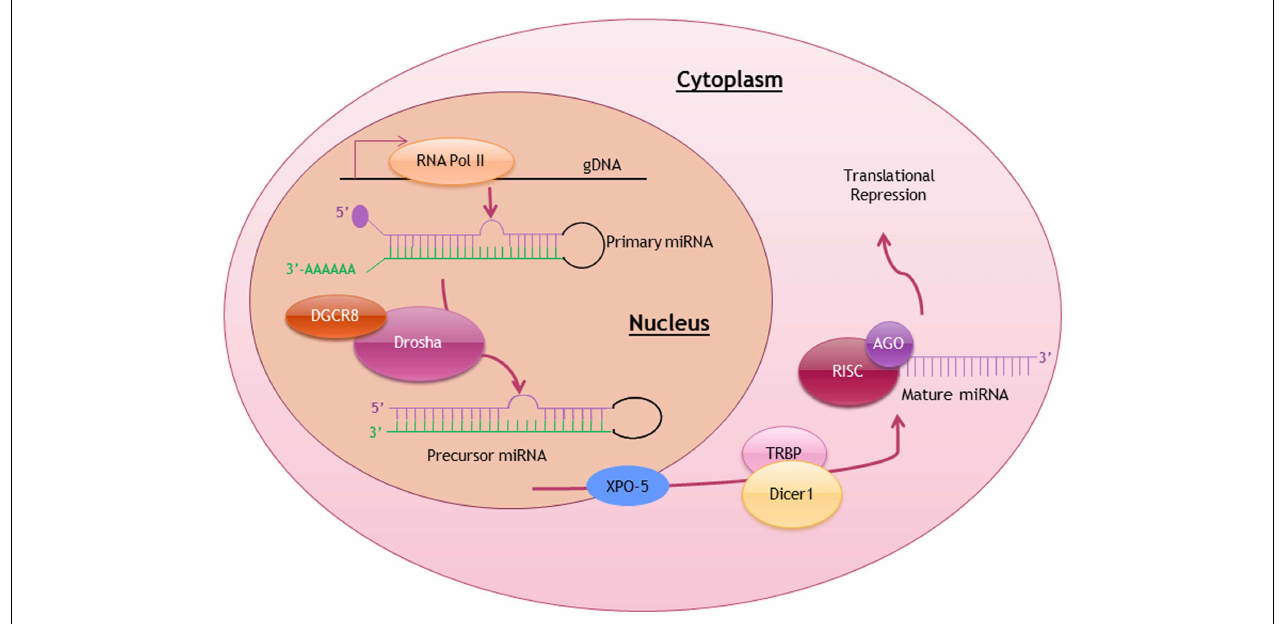
RNA polymerase II; DGCR8, DiGeorge syndrome critical region gene-8; XPO-5, exportin-5;TRBP,TAR-binding protein; RISC, RNA-induced silencing complex; AGO,